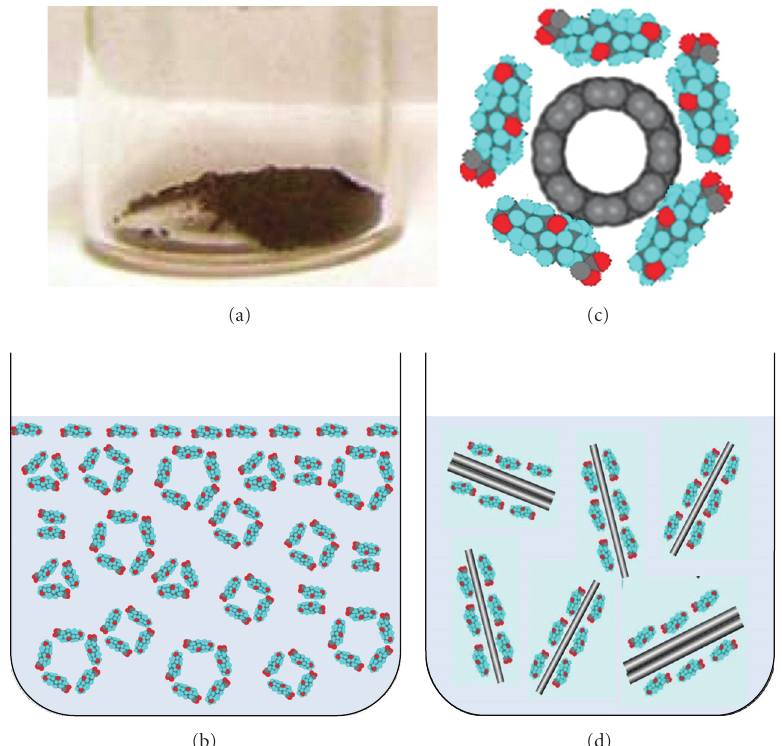
Figure 3: (Color) Schematics of SWNT dispersion mechanism in water by physical adsorption of dispersant molecules. (a) SWNTs powders. (b) Surfactant micelles formation in aqueous solution. The insertion of SWNTs in the surfactant aqueous solution and the ultrasonic treatment cause the wrapping of surfactants around SWNT sidewalls. The surfactants wrap with their nonpolar tail the SWNT sidewalls while extending their polar or ionic end in contact with aqueous solution. (c) Cross-sectional view of the possible arrangement of the SDC molecules around the SWNT sidewalls. (d) Final dispersion with individual and bundled SWNTs wrapped by surfactant